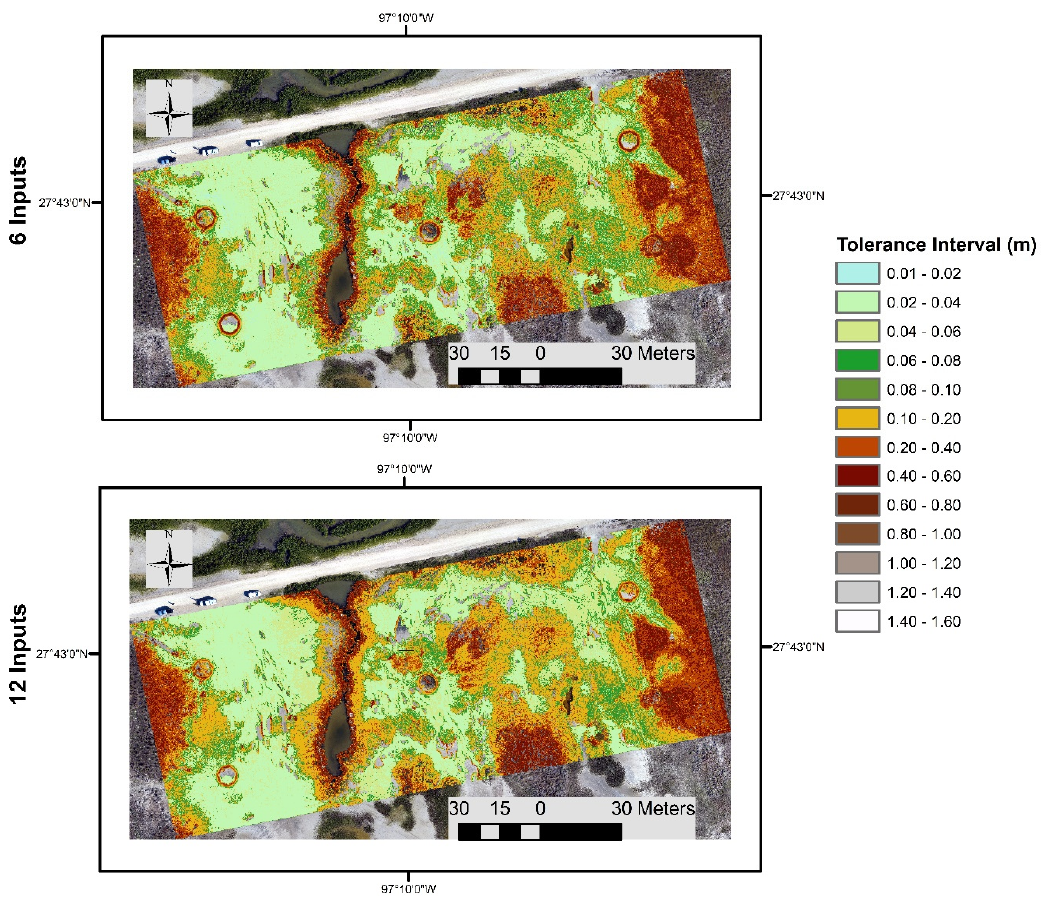
Figure 9. Ninety-five percent tolerance intervals / uncertainty ranges of ENN corrections of 6 ( top ) and 12 inputs ( bottom ) for the 47th selected run from Section 4.1.